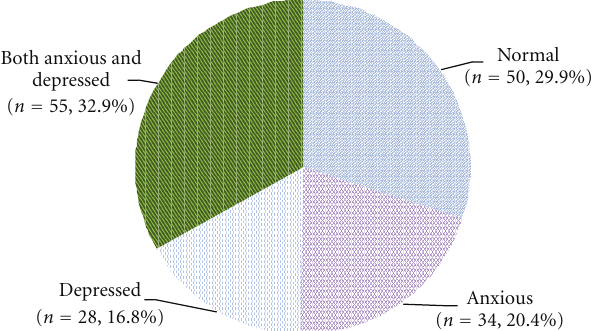
Figure 1: Distribution of study participants by their anxiety and depression status ( n =